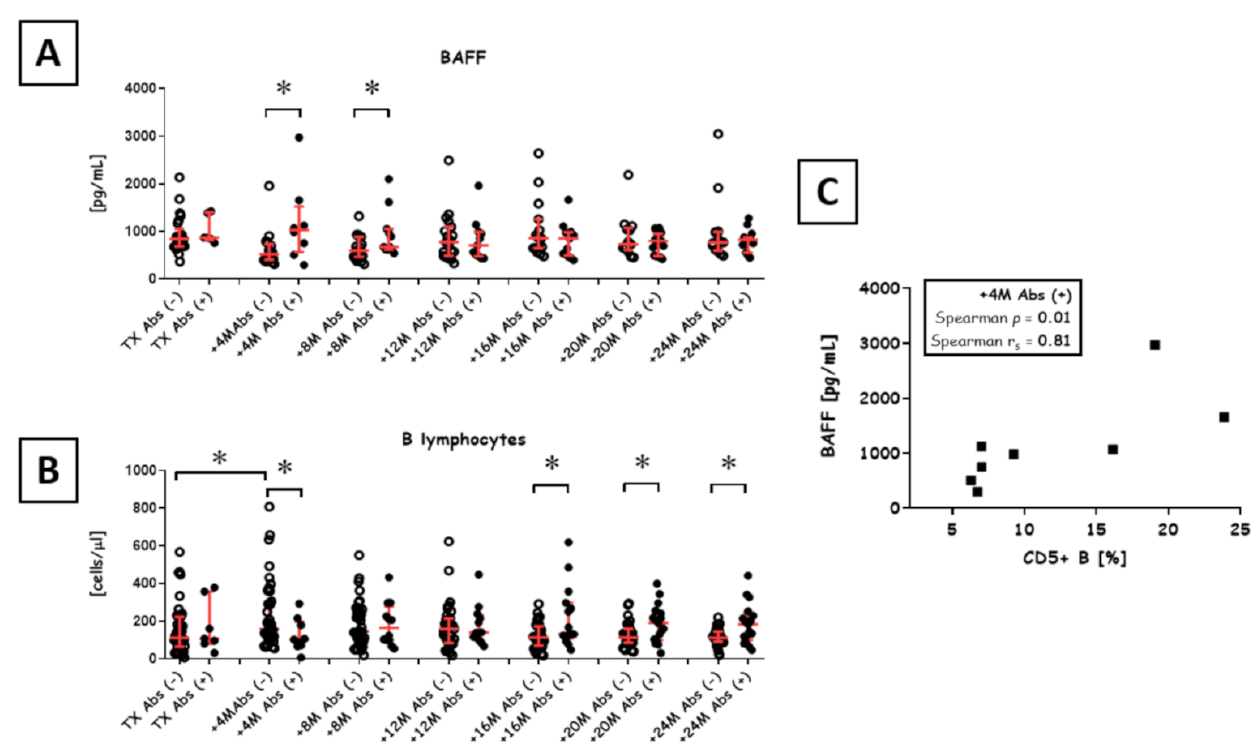
Figure 2. BAFF and absolute B cells levels during the first 2 y post-transplant. ( A ) . Serum BAFF levels in Abs − (open circles) and Abs+ (black circles) patients were compared for each time point. * p < 0.05 based on Mann-Whitney U tests. The ratio of Abs − to Abs+ recipients at measured time points was as follows: transplant (45/7), +4 months (42/9), +8 months (40/12), +12 months (37/14), +16 months (35/15), +20 months (33/17) and +24 months (32/19). ( B ) The correlation between BAFF ( n = 9) and CD5+ B cells ( n = 9) 4 months post-transplant in Abs+ recipients, as determined with Spearman rank correlation tests (r s , significant if p < 0.05). ( C ), an absolute number of cells (cells/ µ L). Absolute B cell frequency in Abs − (open circles) and Abs+ (black circles) patients ( n = 52) were compared for each measured time point, from transplant up to 2 y post-transplant. * p < 0.05 (U tests). The ratio of Abs − to Abs+ recipients at measured time points was as follows: transplant (45/7), +4 months (42/9), +8 months (40/12), +12 months (37/14), +16 months (35/15), +20 months (33/17) and +24 months